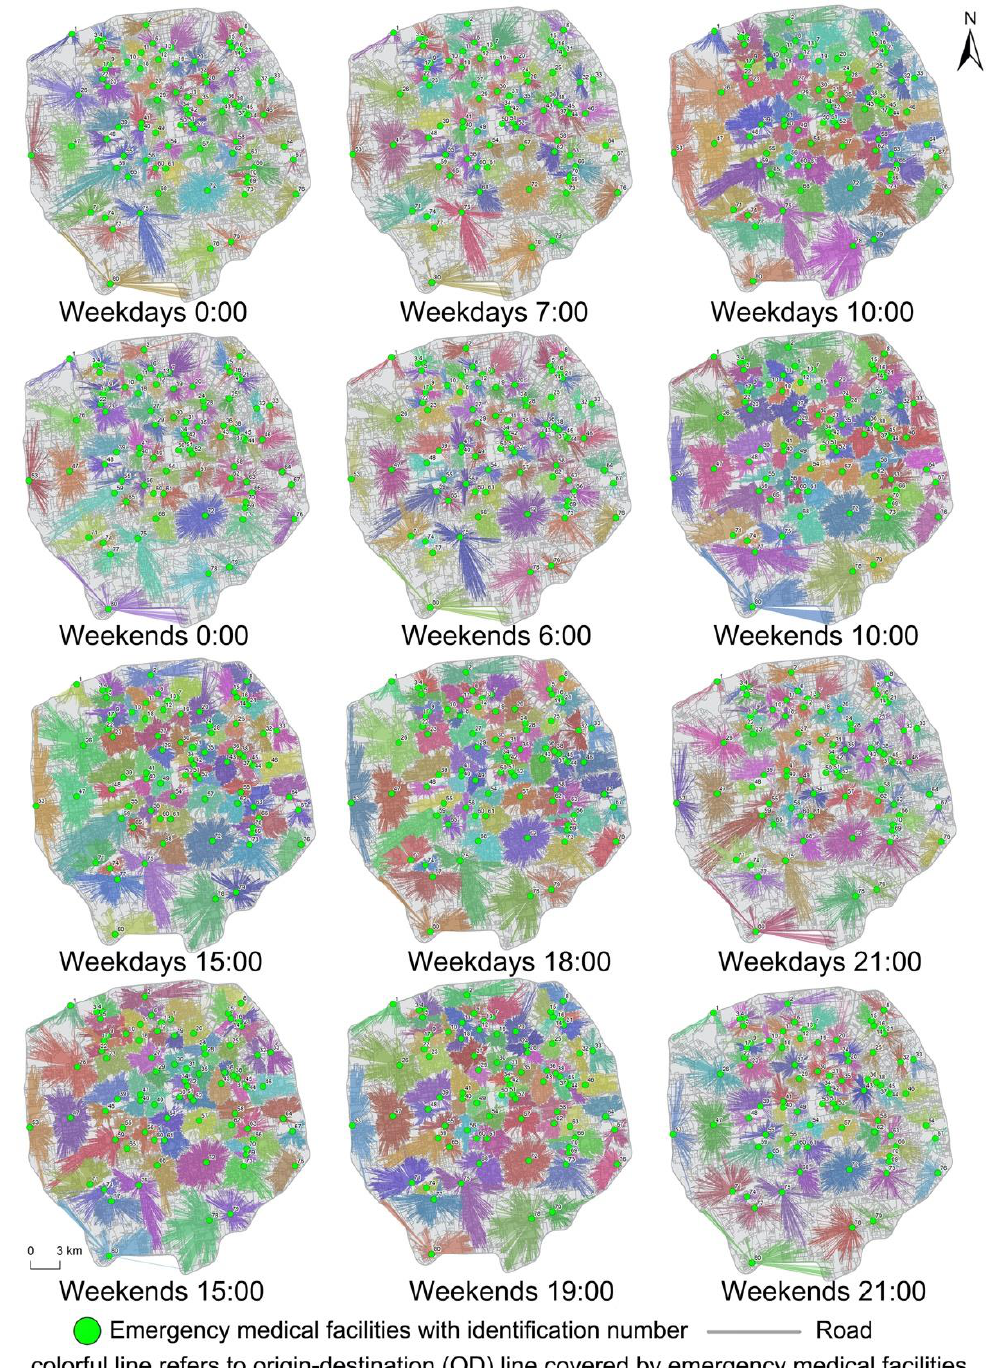
Figure 5. The coverage distribution of emergency medical facilities at different times.